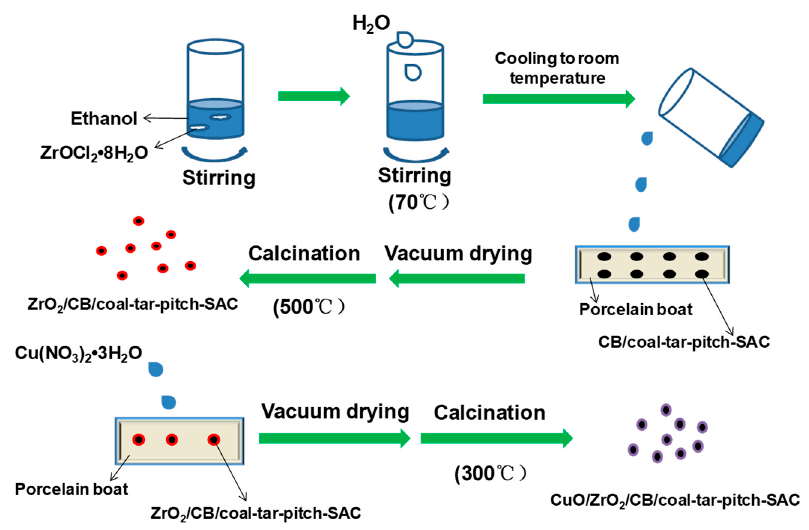
Figure 1. Images of fabrication process of CuO/ZrO 2 /CB/coal-tar-pitch-SAC materials.